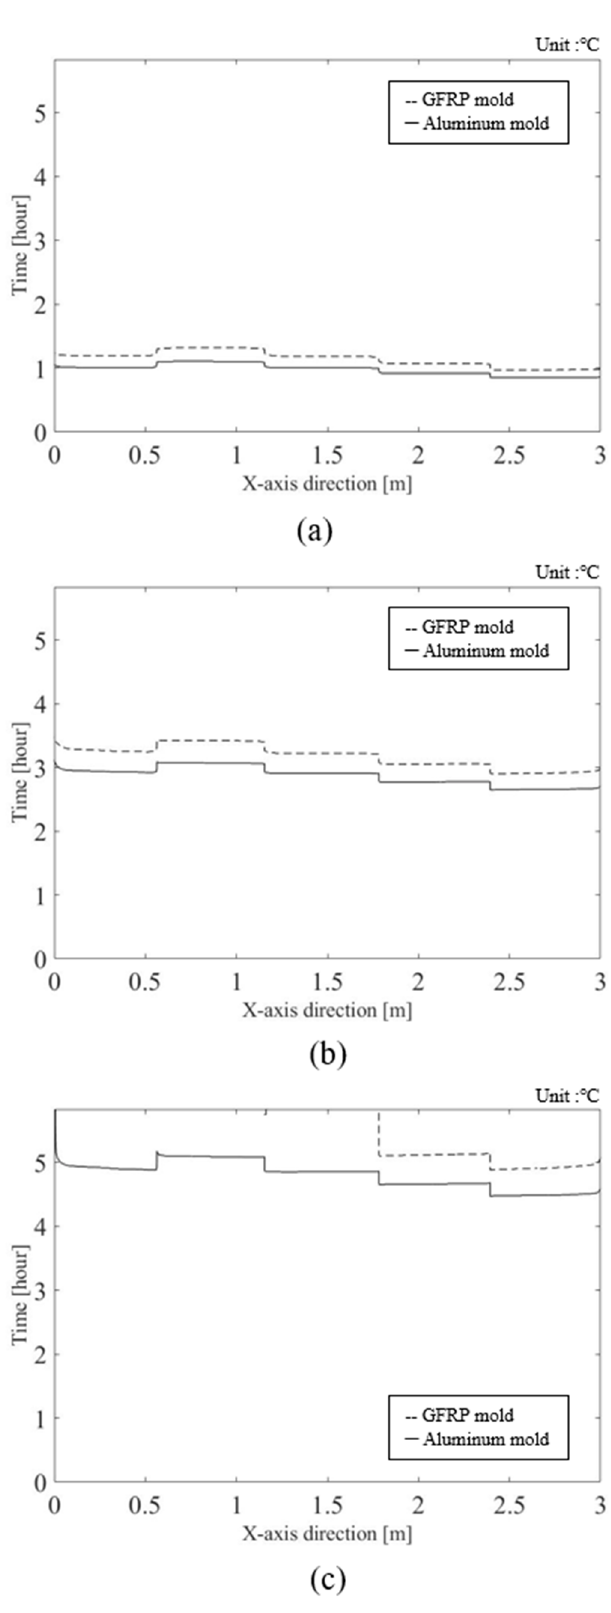
Figure 9. Top surface temperature of spar-cap on transient state analysis (case 4 at reference models): ( a ) 40 °C; ( b ) 60 °C; ( c ) 80 °C.